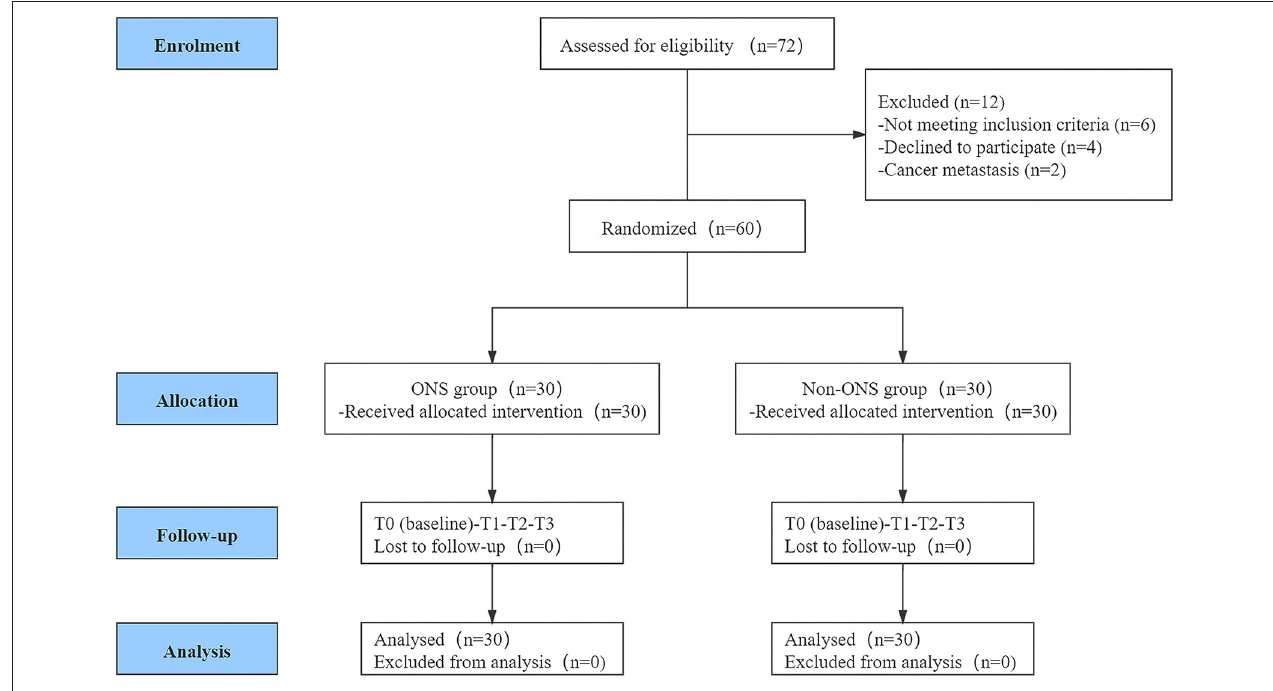
FIGURE 1 | CONSORT flow